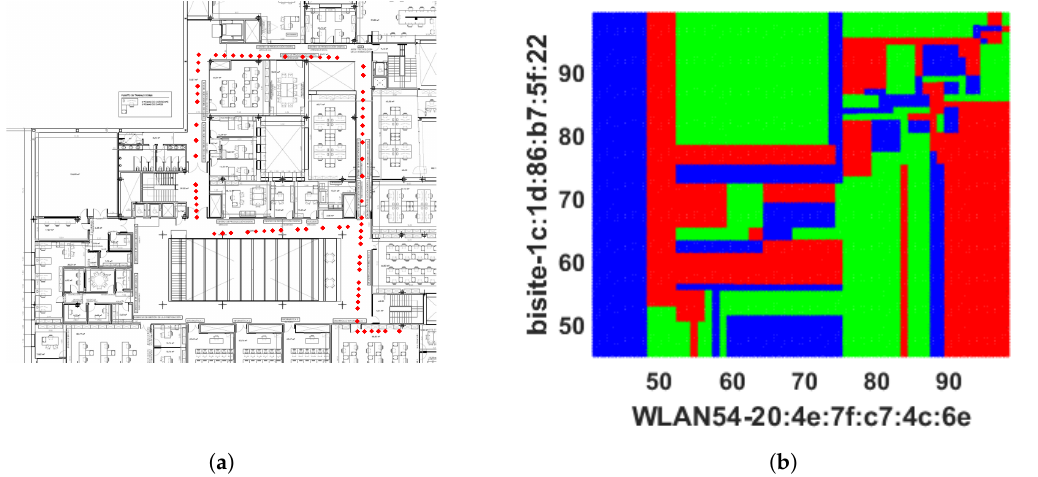
Figure 4. Prediction results obtained from DT classifier: ( a ) the route predicted by DT classifier; and ( b ) 2D decision boundary formed by DT classifier.